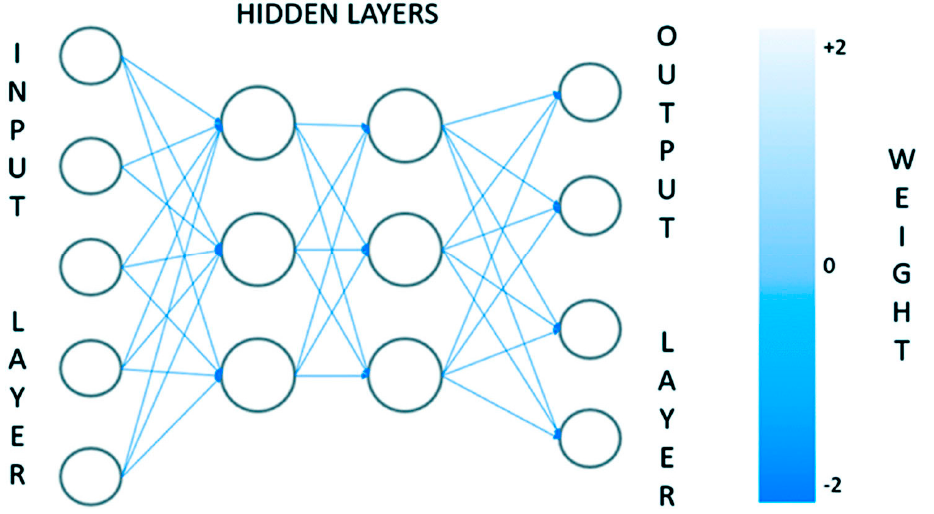
Figure 32. Schematic of an ANN architecture [127].